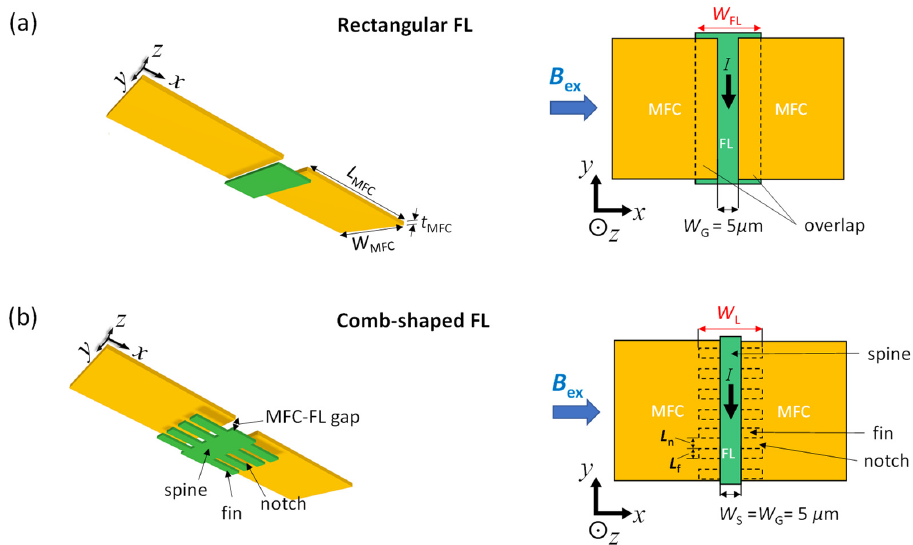
Figure 3. 3D and 2D schematics of the GMR sensors with ( a ) a conventional rectangular FL and ( b ) a comb-shaped FL. The schematics are not proportional to actual lengths. MFC-FM overlaps exist for W FL , W L > W G .